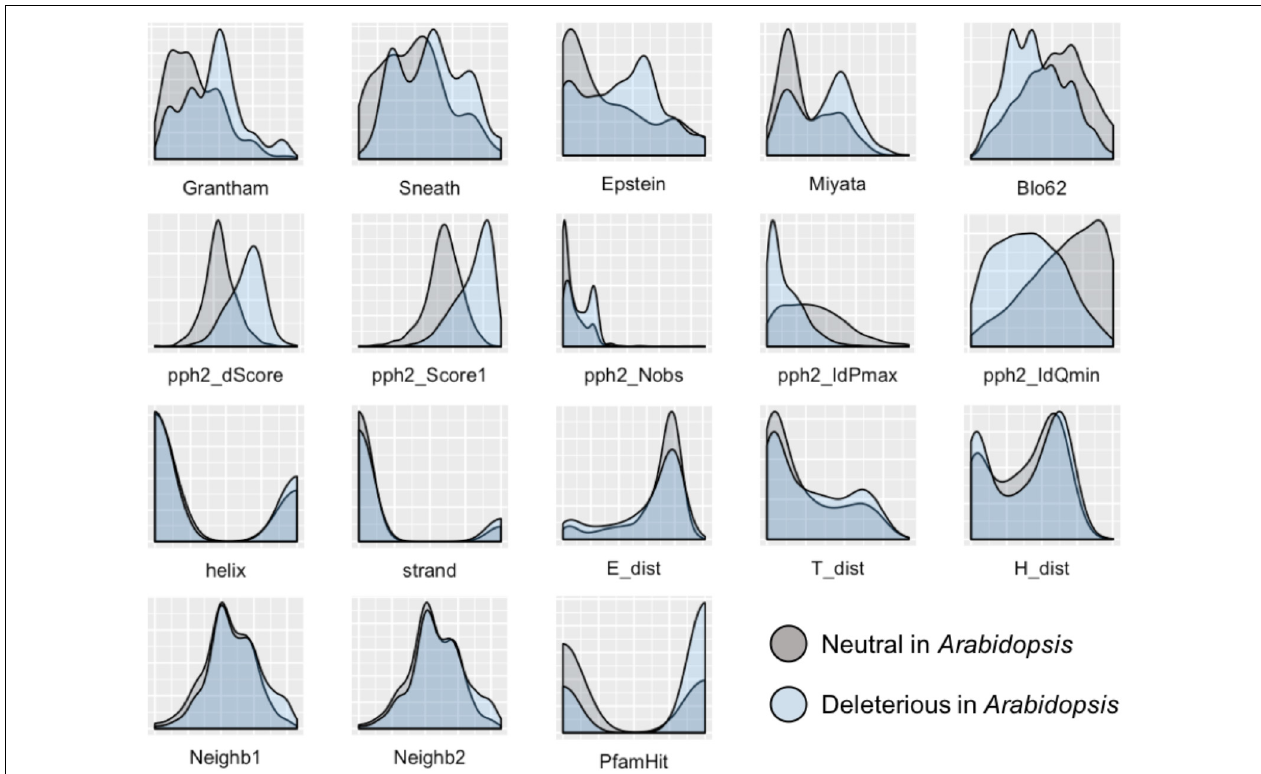
FIGURE 1 | Distribution of features used to characterize the impact of amino acid substitutions in protein sequence for subsets of neutral and deleterious mutations in Arabidopsis thaliana . The first row of features – Grantham, Sneath, Epstein, Miyata, and Blo62 (BLOSUM62) – represents distributions of substitution scores based on five corresponding distance matrices. The second row represents the scores obtained with the PolyPhen-2 service: pph2_Score1 and pph2_dScore reflect PSIC scores; pph2_IdPmax, pph2_IdQmin, and pph2_Nobs represent specific features based on the multiple protein alignments. The third row contains features of the secondary protein structure: two features of belonging to helix or strand (helix, strand), and three scores obtained with PCI-SS service (E_dist, T_dist, H_dist). The last row includes two features of the amino acid context around the substitution of interest (Neighb1, Neighb2) and belonging to known Pfam domains (PfamHit). The detailed explanation of features are presented in the Supplementary Table S1